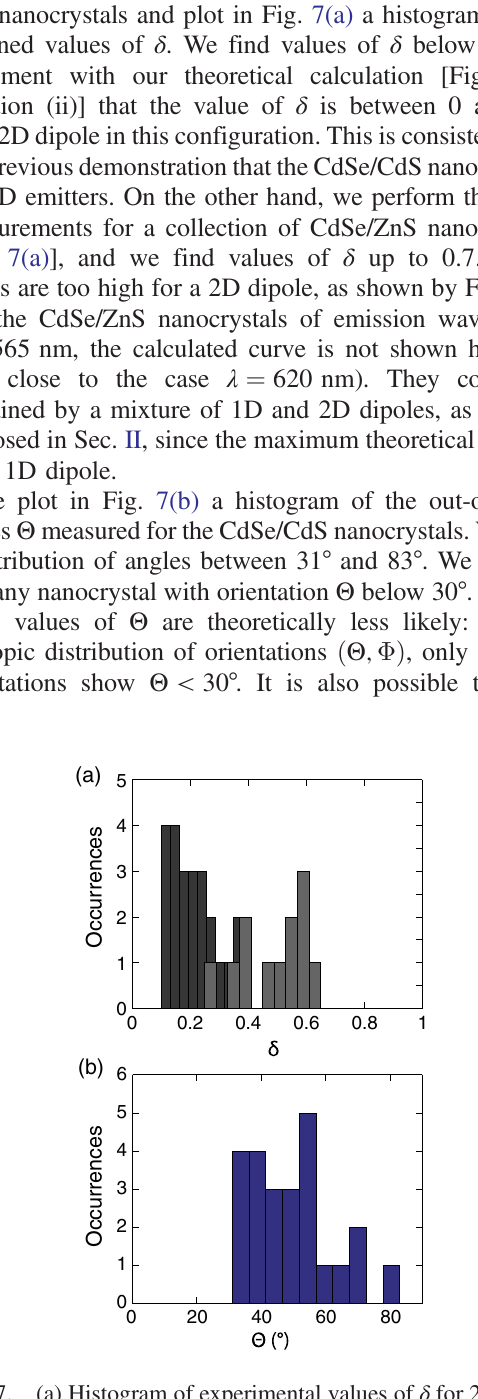
FIG. 7. (a) Histogram of experimental values of δ for 24 CdSe/ CdS nanocrystals (black bars) and 13 CdSe/ZnS nanocrystals (grey bars). (b) Histogram of experimental values of Θ for 24 CdSe/CdS